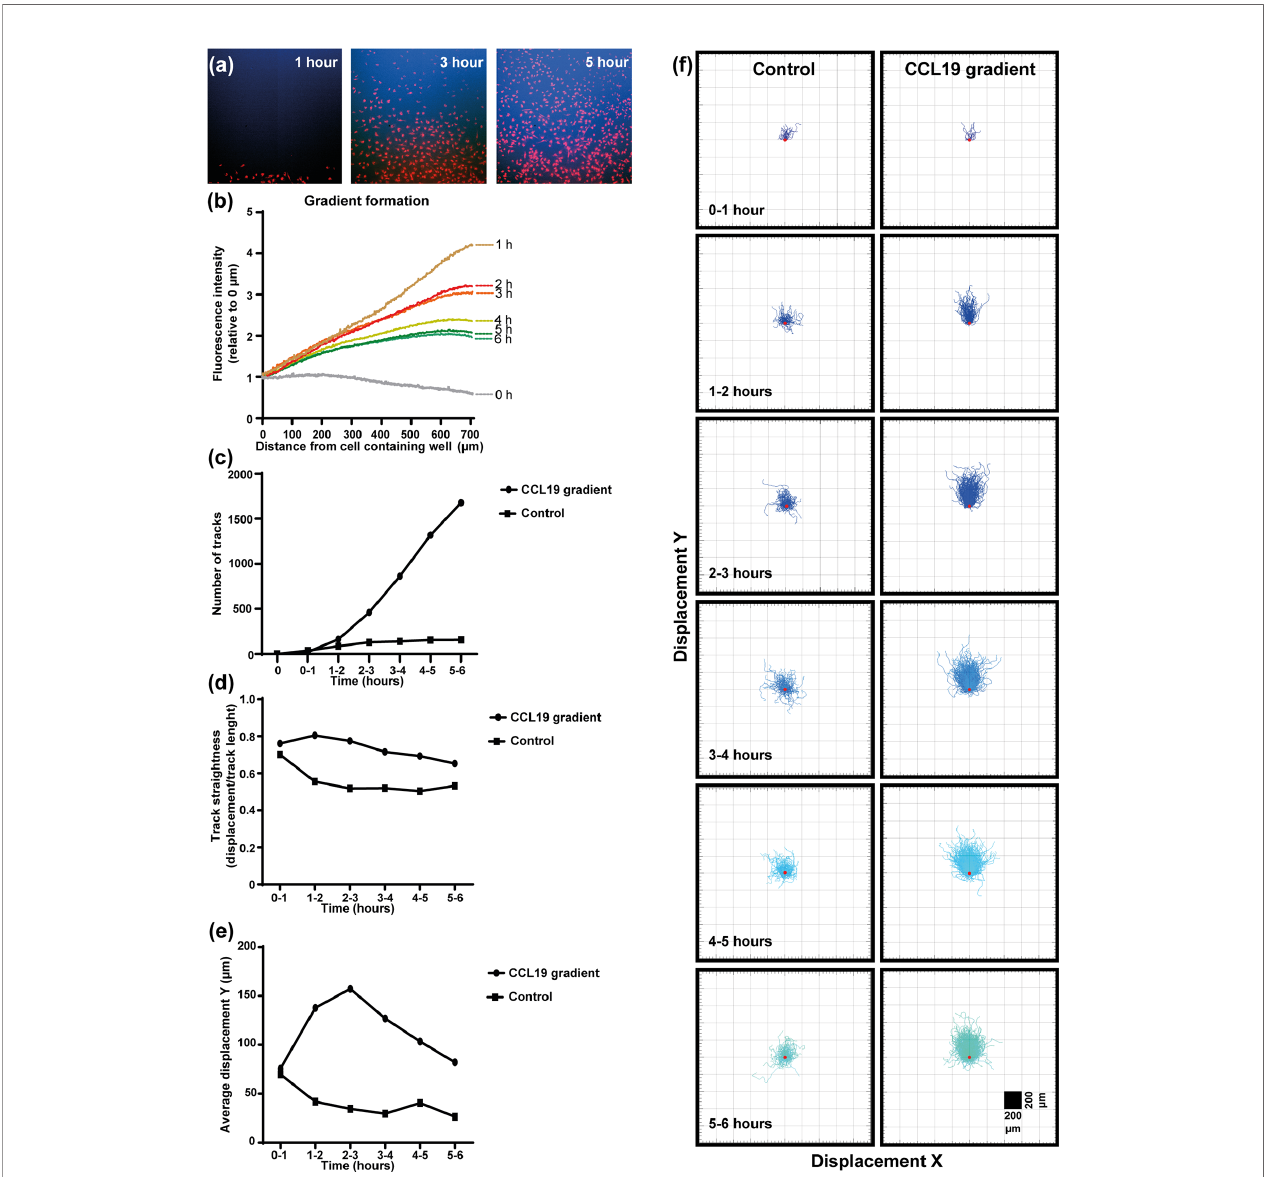
FIGURE 1 | Dendritic cells respond chemotactically to a cytokine gradient in the "under-agar" assay, which lasts for several hours as shown by fl uorescent dextrans. (A) Images showing the diffusion of fl uorescent dextran (blue) a nd migration of mDCs (red) at one, three and fi ve hours of incubation. (B) The formation of a gradient in the under-agar assay as shown by diffusion of 10 kDa dextrans. (C) Graph showing the number of tracked mDCs over time in response to a CCL19 gradient or no chemokine (control). (D) Graph showing the track straightness of mDCs over time in response to a CCL19 gradient or no chemokine (control). (E) Graph showing the displacement of mDCs in the direction of the CCL19 gradient or in the same direction without chemokine (control). (F) "Spider plots" showing the tracks of mDCs over time in response to a CCL19 gradient or no chemokine (control) plotted from a single origin point (red dot). All data is from one representative experiment that was repeated at least three